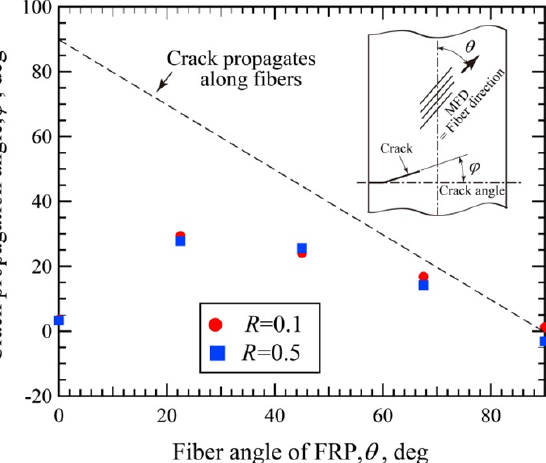
Figure 2: Fatigue cracks in MD, 45°, TD specimens of IMP under